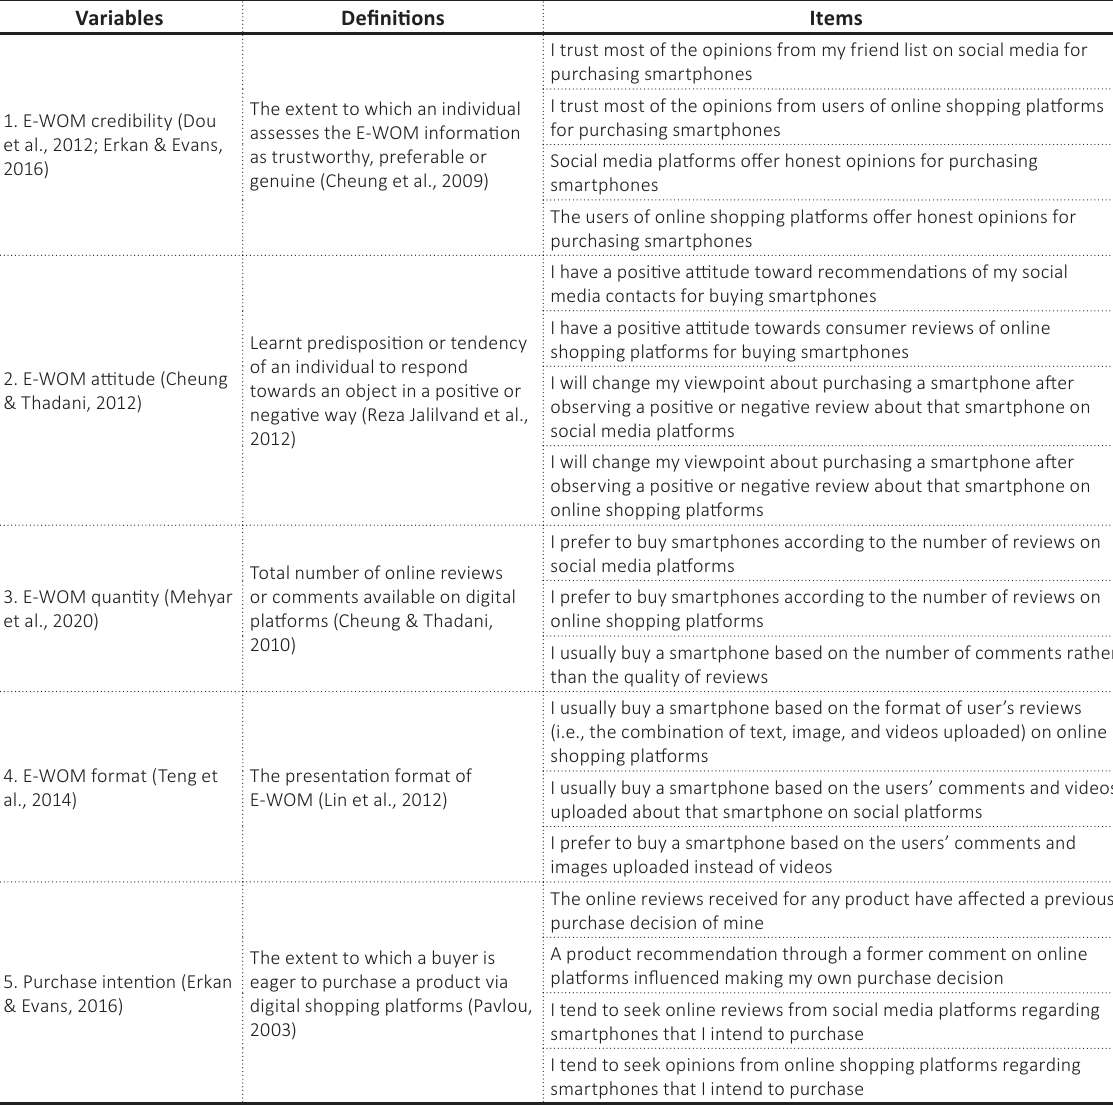
Table 1. Variables and